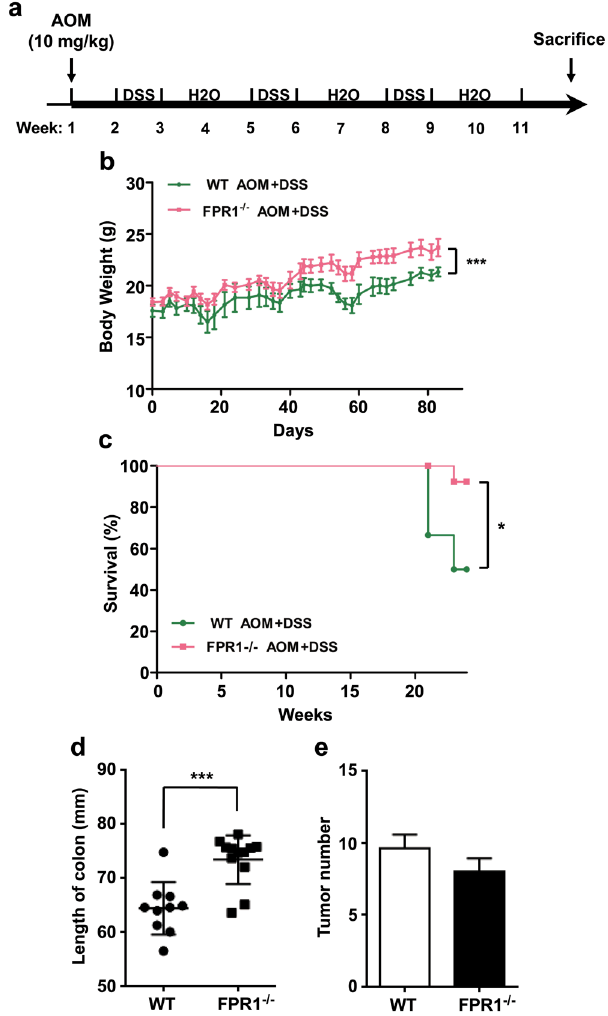
Figure 6. FPR1 involvement in mouse survival in a colorectal cancer model. ( a ) Schematic representation of the mouse model of CRC, as described in the Materials and Methods section. Body weights ( b ) and survival ( c ) of WT (green line) mice and fpr1 − / − (red line) mice with CRC. Also shown are quantification of colon length ( d ) and tumor number ( e ) in WT mice and fpr1 − / − mice with CRC. (6 mice for WT group; 13 mice for fpr1 − / −